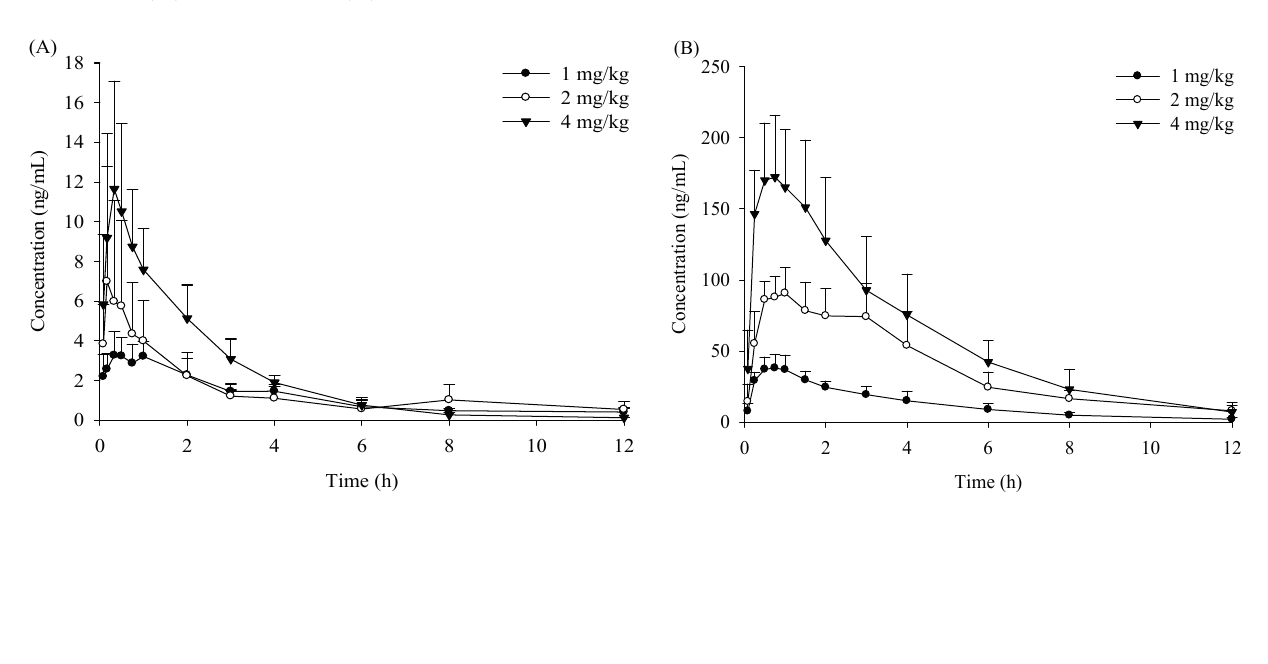
Figure 2. Time-concentration profiles of verticinone after oral dose of 1, 2 and 4 mg/kg in rats. ( A ) female rats; ( B ) male